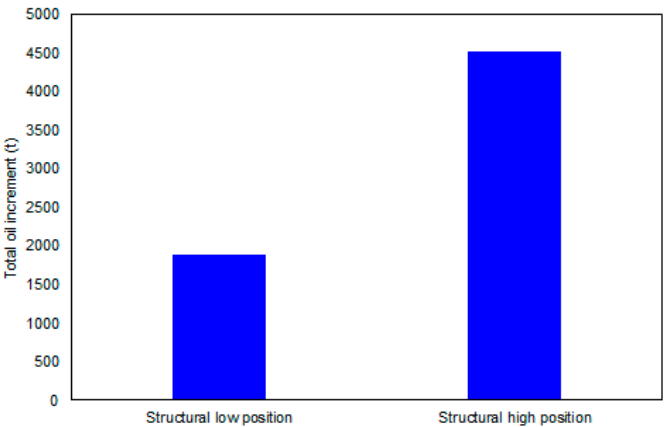
Figure 34. Oil increment at different structural positions.